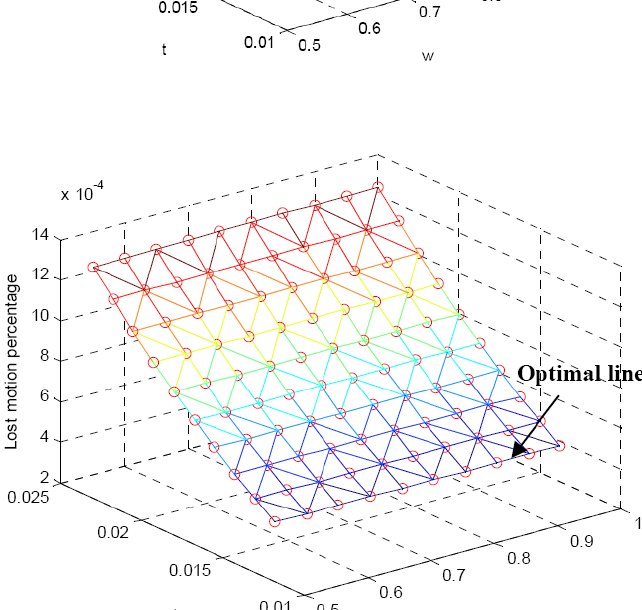
Figure 8. Lost motion